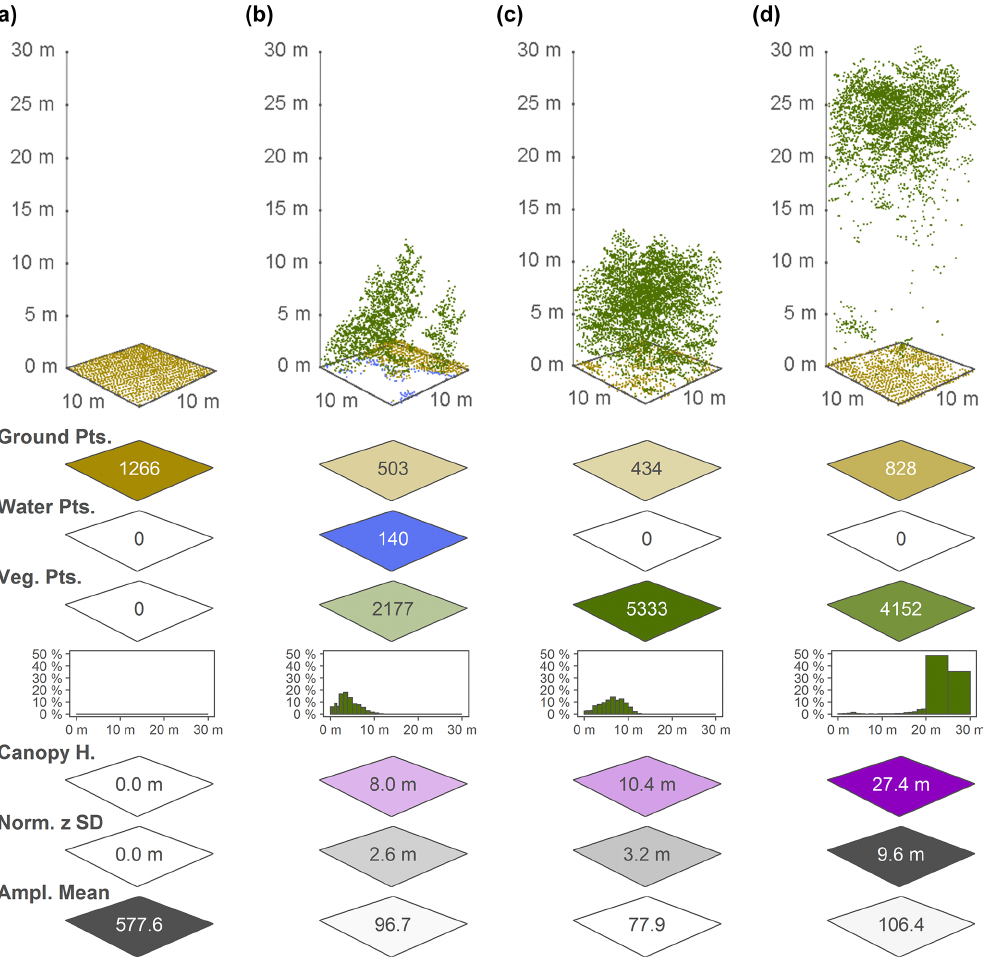
Figure 3. Point cloud examples for four 10m × 10m cells and a selection of the associated EcoDes-DK15 descriptors derived from the point clouds, illustrating the ecological meaning and some of the limitations of the EcoDes-DK15 data set. The 10m × 10m cells represent the following environments: (a) an agricultural field, (b) the edge of a forest/parkland pond with low vegetation, (c) a young plantation of dense coniferous trees and (d) old growth mixed woodland. The EcoDes-DK15 descriptors shown include (from the top) the total point counts for each cell in the three main EcoDes-DK15 categories: (1) the number of returns classified as ground, (2) the number of returns classified as water and (3) the number of returns classified as vegetation. In addition, the relative proportion of vegetation points per predefined height bin is illustrated below the total vegetation point count. Finally, the bottom three panels show the estimated canopy height (altitude above ground for the 95% percentile of all vegetation returns), the normalised z standard deviation (variation in height above ground for all return classes) and the mean return amplitude for each cell. Please note how the classification of the point cloud does not separate between very low-growing vegetation (e.g. grass) and ground points in the agricultural field shown in (a) , as well as how returns from water are only registered in shallow areas close to the water body’s edge, as exemplified by the forest pond in (b) . Lastly, we would like to point the reader to the general limitations of ALS in penetrating forest canopies such as those shown in (c) and (d) . While the upper layers of the canopies are well resolved in both cases, the laser scanning struggles to capture some aspects of the lower layers; the ground returns were frequently blocked by the thick canopy in (c) , and the laser fails to meaningfully characterise understorey vegetation and stems in (d) .